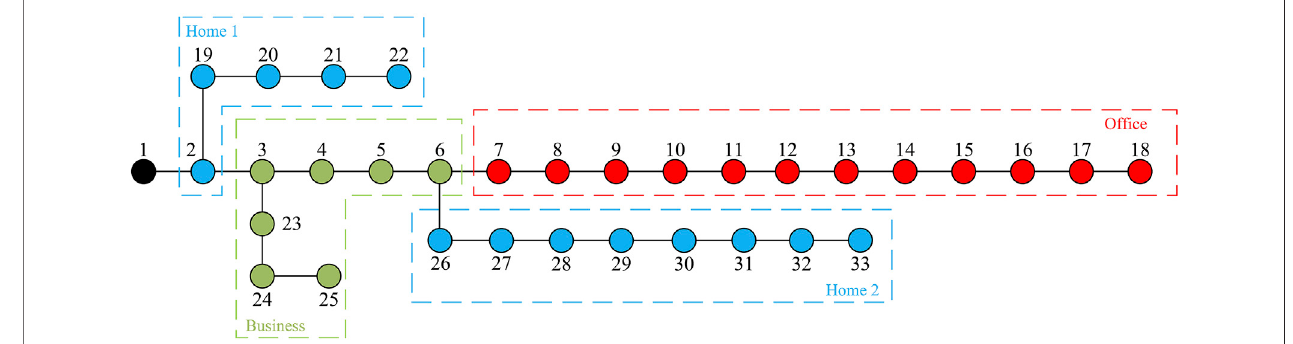
FIGURE 5 | Adapted IEEE-33 node system region division diagram.